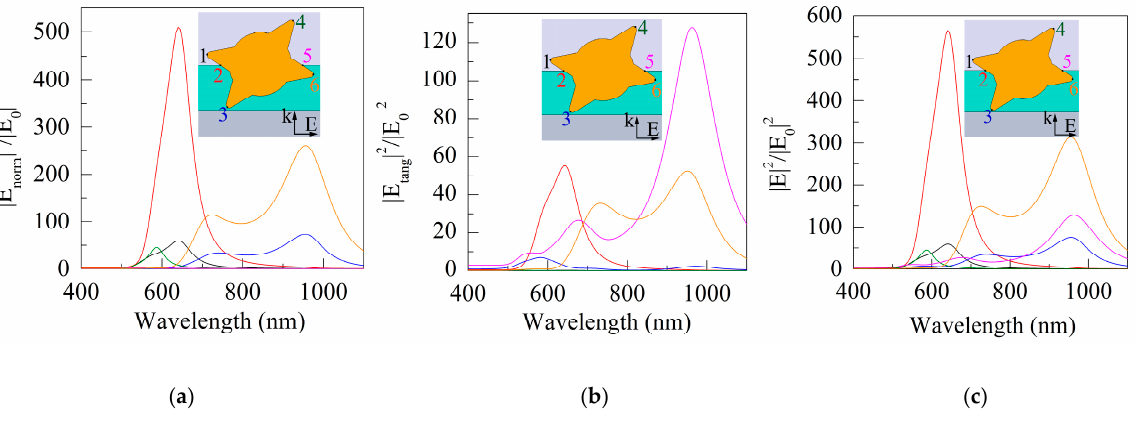
Figure 8. Spectral curves for the squares of the modules of normal | E normal | ( a ), tangential | E tang | ( b ) field components and total field ( c ) normalized to the square of the modulus of the irradiating field | E 0 | at six specified points on the GNS surface. The designations of points and curves are the same as in Figure 6.